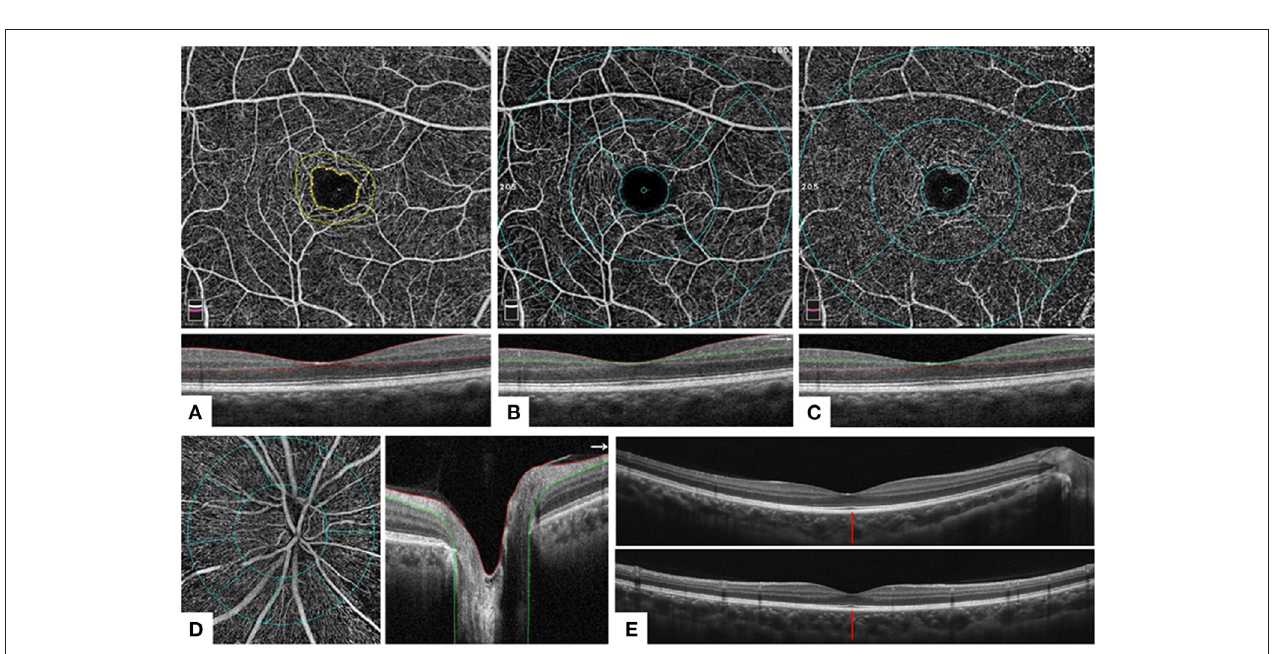
FIGURE 2 | Optical coherence tomography and optical coherence tomography angiography measurements. (A) A 6 × 6mm OCTA image (above) of the corresponding layer in the macular area of the whole inner retina [below: a horizontal OCT B-scan of internal limiting membrane (ILM)–outer plexiform layer (OPL), area between two red lines]. Foveal avascular zone (FAZ): area surrounded by the inner yellow line. (B) A 6 × 6mm OCTA image (above) of the corresponding layer of the macular area in the superficial retina [below: horizontal OCT B-scan of ILM–inner plexiform layer (IPL), area between red and green lines]. Foveal area: area surrounded by the inner blue ring (ring diameter = 1mm); parafoveal area: area between the middle (ring diameter = 3mm) and inner blue rings; perifoveal area: area between the outer (ring diameter = 6mm) and middle blue rings. The four quarters were divided by four blue lines. (C) A 6 × 6mm OCTA image (above) of the corresponding layer of the macular area in the deep inner retina [below: horizontal OCT B-scan of IPL–OPL, area between green and red lines]. Sections division was the same as (B) . (D) A 4.5 × 4.5mm OCTA image (left) of the corresponding layer in the radial peripapillary capillaries layer (right: horizontal OCT B-scan of ILM–retinal nerve fiber layer, area between red and green lines) of the optic nerve head (ONH). Peripapillary: area surrounded by the inner blue ring; inside disc: area between two blue circles (the width is 1mm). Eight sectors were divided by eight blue lines. (E) A horizontal (above) and a vertical (below) OCT B-scan of the retina. The distance of the red line: sub-foveal choroidal thickness, defined as the distance between the outermost edge of the retinal pigment epithelium and the sclera–choroidal border.